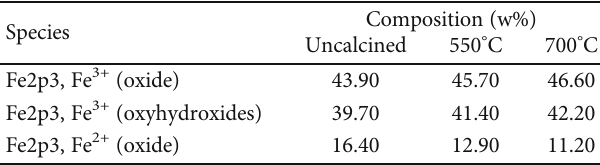
Table 3: Fe species on the MNZ/Fe